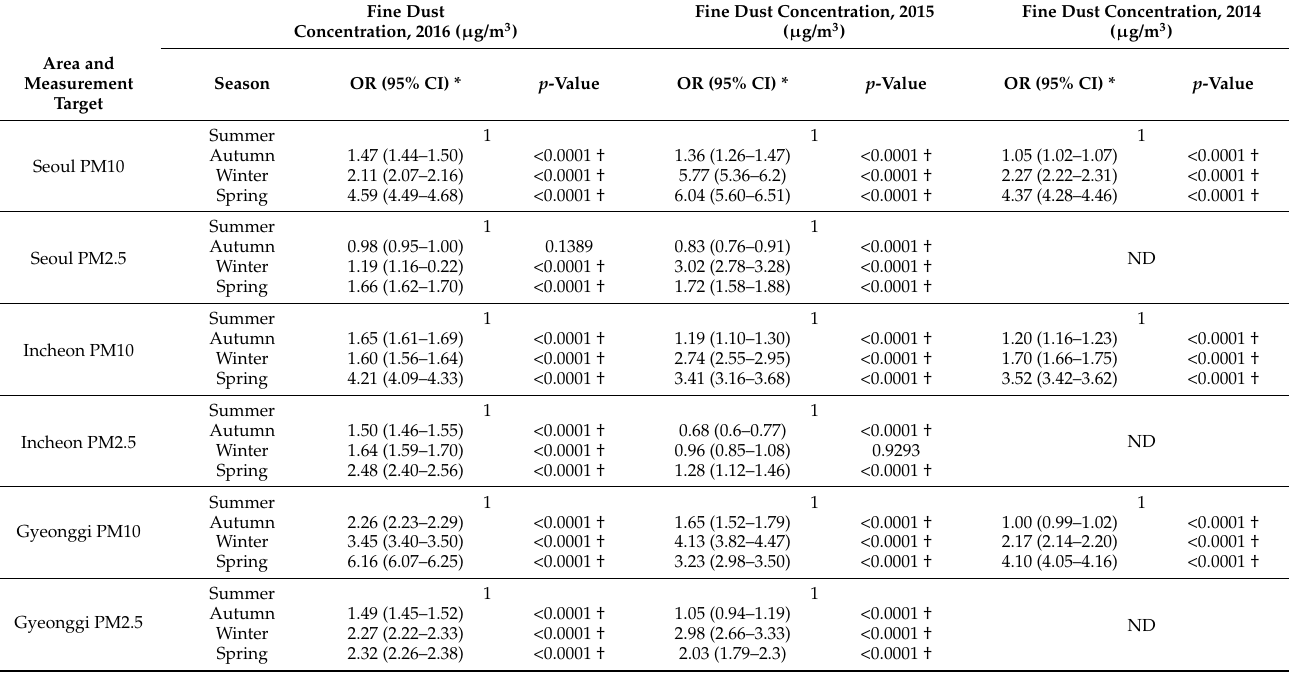
Table 5. Correlation (OR) between the concentration of average fine dust (PM10 and PM2.5) and season (log-linear). Fine Dust Concentration, 2016 ( µ g/m 3 )